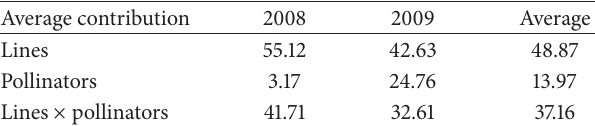
Table 3: Genotypic variance components for root yield. Components